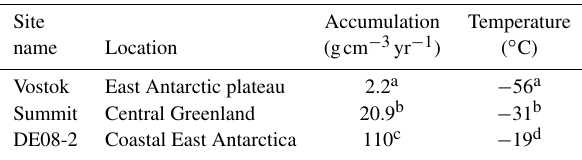
Table 1. Characteristics of the three investigated polar sites. Site Accumulation Temperature